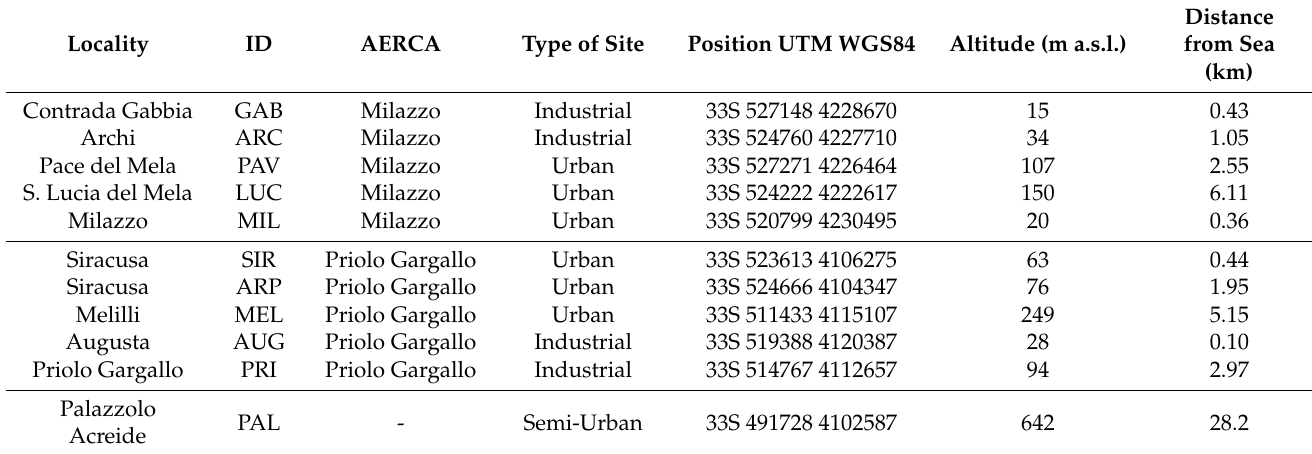
Table 1. The collector network and information of monitoring